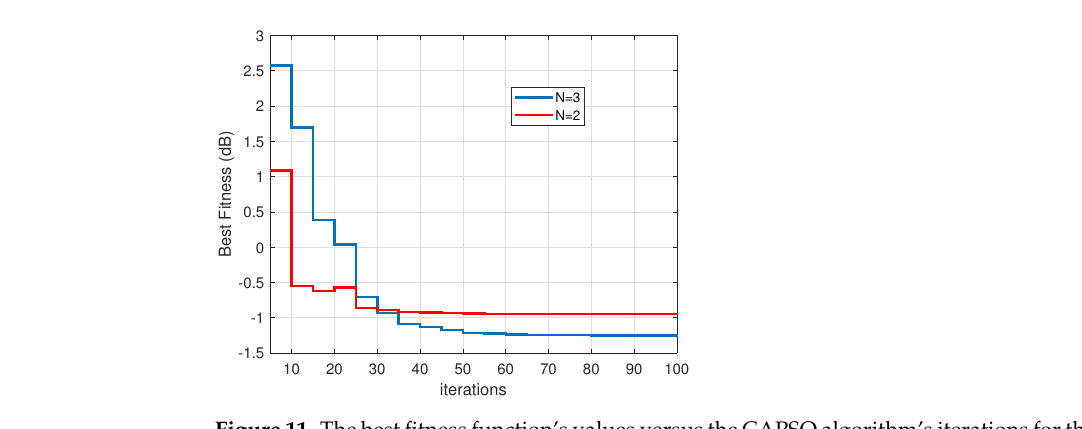
Figure 11. The best fitness function’s values versus the CAPSO algorithm’s iterations for the scattering problem considered in Figure 10, presented in a stairstep graph with a 5-iteration step.